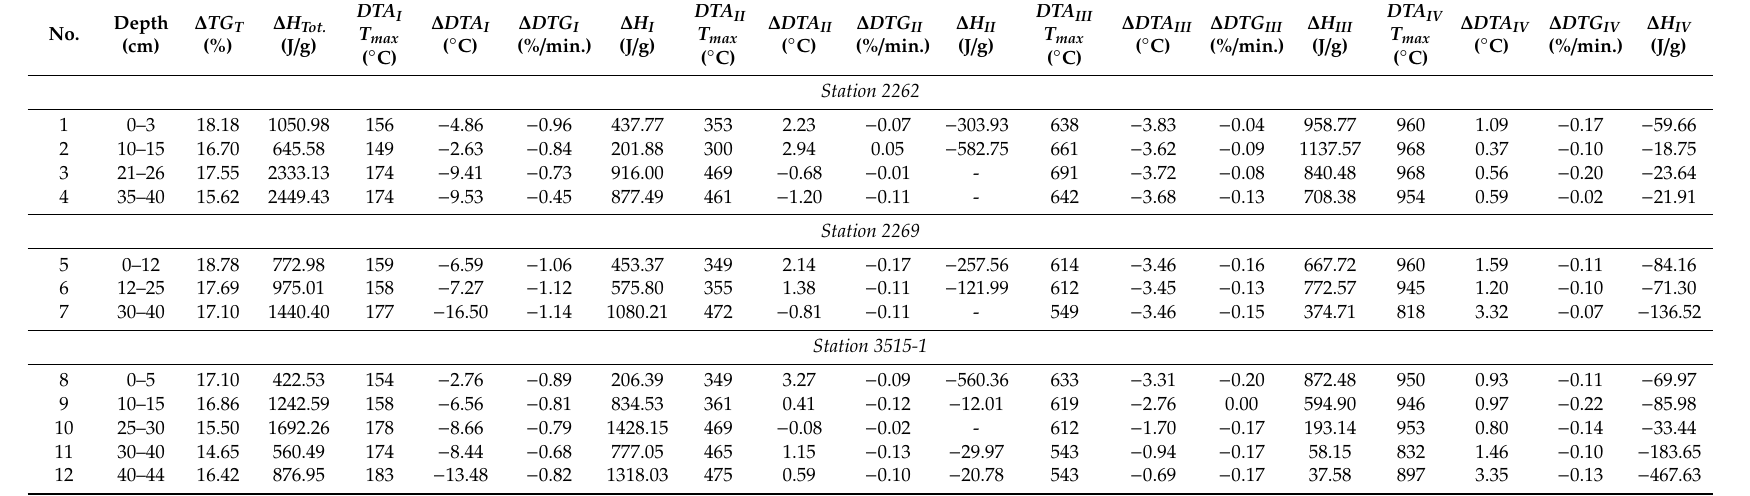
Table 4. Thermokinetics data of samples from the IOM claim area ( n =